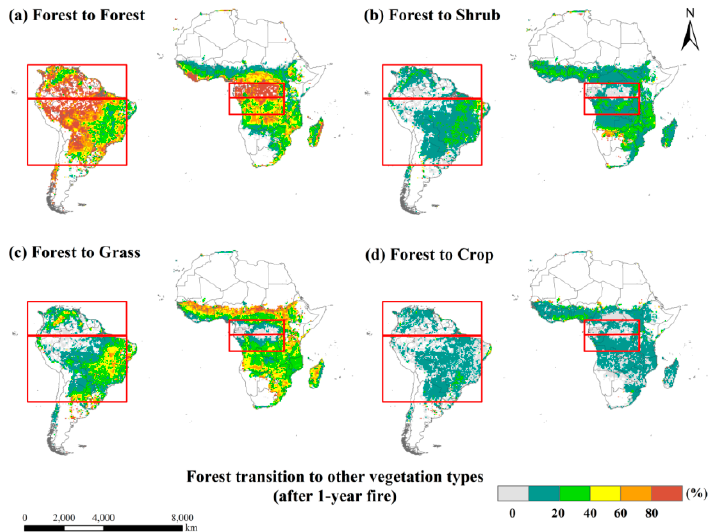
Figure 4. The spatial distributions of the vegetation changes in forest regions in the first year after a fire. ( a ) Forest to Forest; ( b ) Forest to Shrub; ( c ) Forest to Grass; ( d ) Forest to Crop. The red rectangles represent the high-density forests (more than 80% of total area in 0.5° grid cell) in Africa and South America.